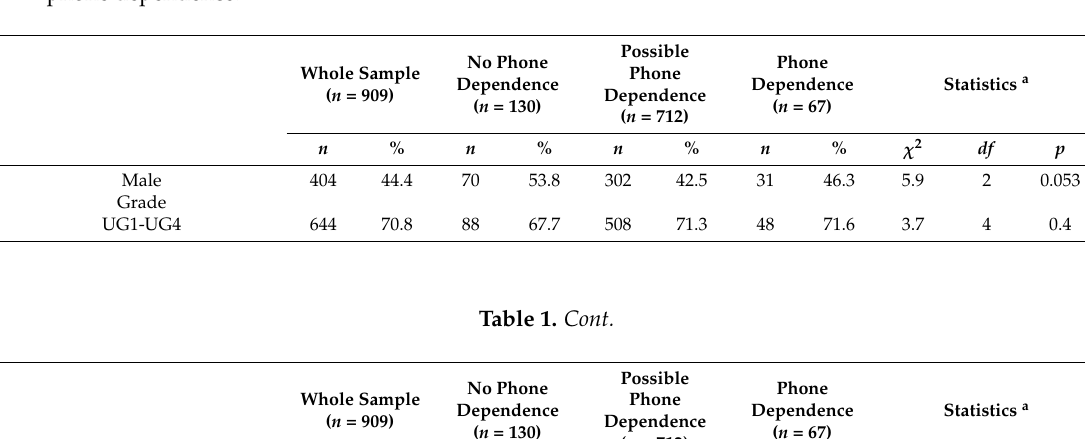
Table 1. Comparison of socio-demographic and clinical characteristics between different groups of phone dependence.